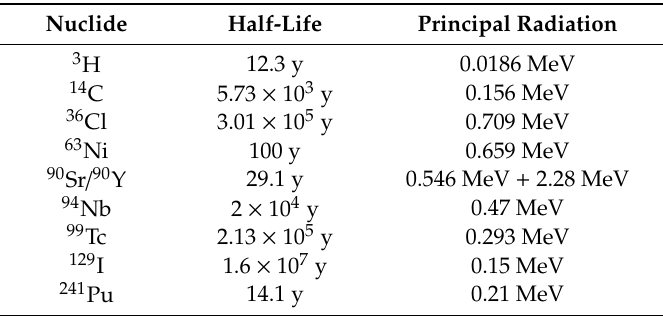
Table 1. Characteristics of beta-ray